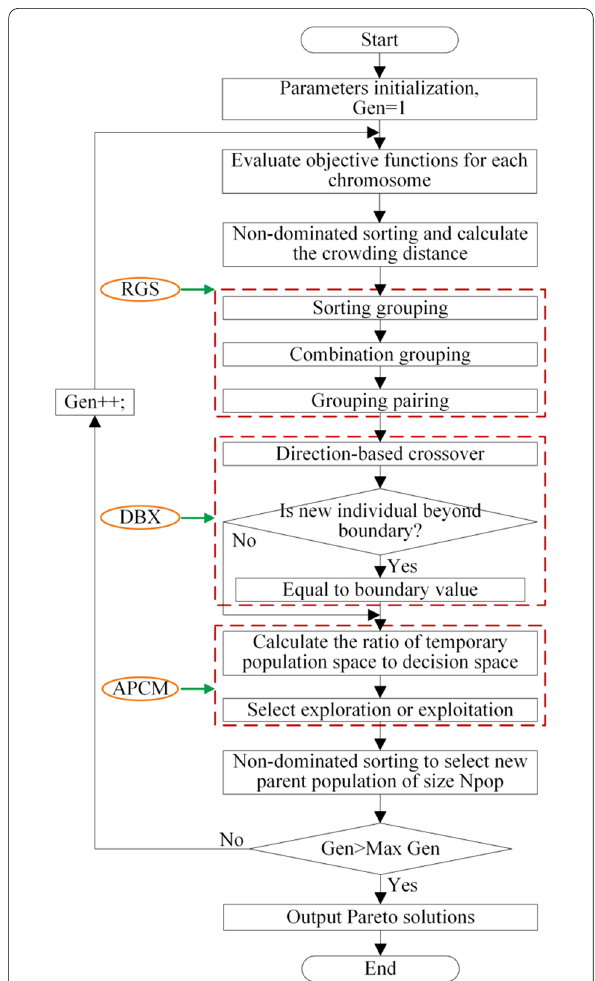
Figure 3 Flowchart of INSGA-II